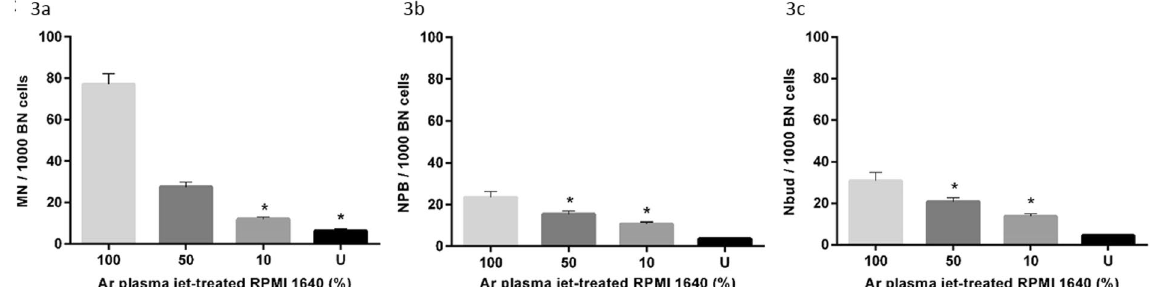
Figure 3. Chromosomal damage in untreated (U) RPMI 1640 and in Ar plasma jet-treated RPMI 1640 (at concentrations of 10, 50 and 100%). Damage was scored in WIL2-NS cells using the CBMN-cyt assay: ( a ) frequency of MN, ( b ) frequency of NPBs, and ( c ) frequency of Nbuds per 1000 binucleated cells. Experiments were performed in triplicate with triplicate samples per experiment ( n = 9). Each point represents the mean value and ± standard error of the mean (SEM) of all repeats. One-way ANOVA was used to determine the statistical significance of the values. The values without a mark above indicate that they are statistically significantly different whereas the values sharing * are not ( P < 0.05).